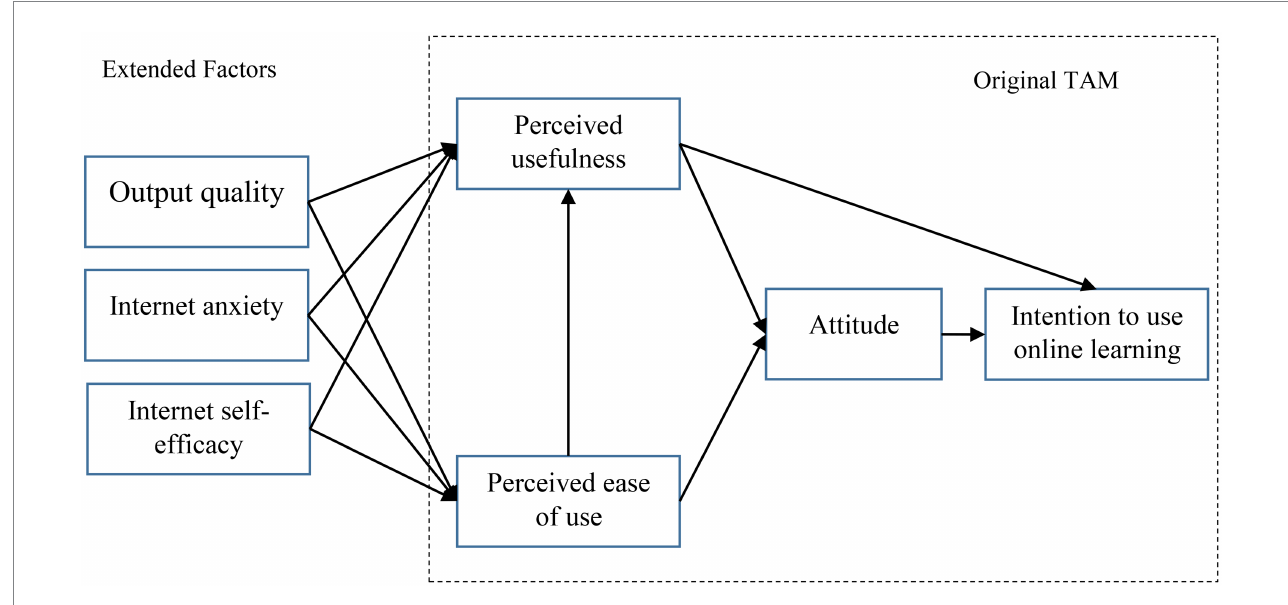
FIGURE 1 Extended